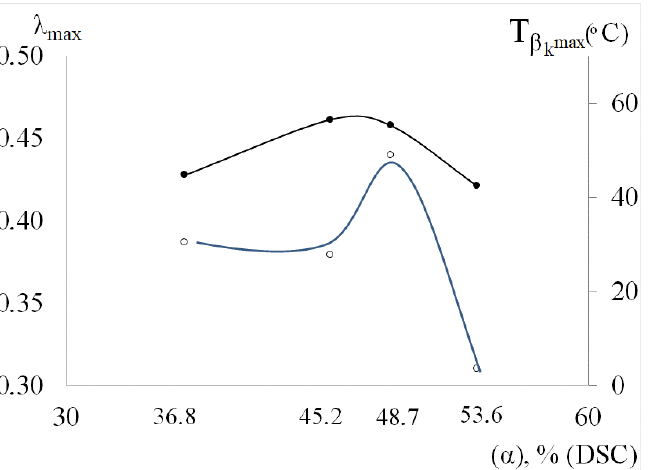
Figure 7. Dependence plot T β degree of crystallinity of the